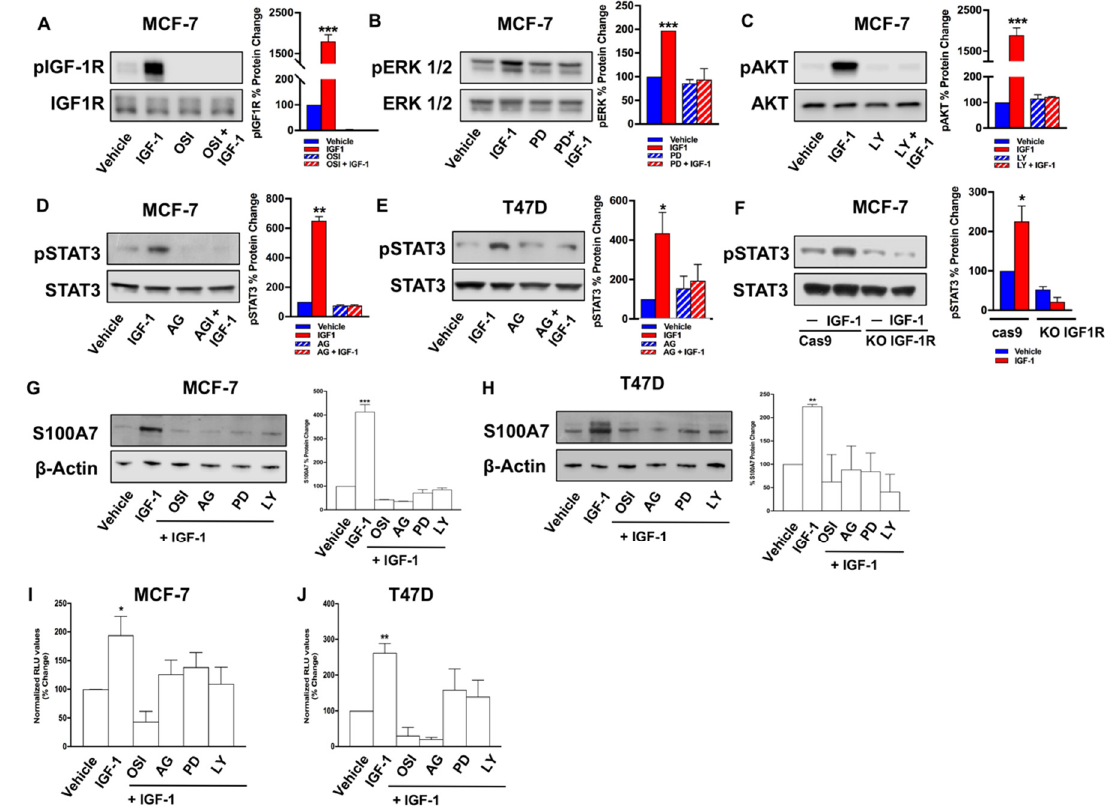
Figure 4. ERK1/2, AKT, and STAT3 signaling pathways are involved in the up-regulation of S100A7 expression induced by IGF-1. Phosphorylation of IGF-1R ( A ), ERK1/2 ( B ), and AKT ( C ) in MCF-7 cells treated with IGF-1 (10 nM, 24 h), alone and in combination with the IGF-1R inhibitor OSI-906 (OSI, 10 µ M) ( A ), the MEK inhibitor PD0325901 (PD, 300 nM) ( B ), as well as the PI3K/AKT inhibitor LY294002 (LY, 10 μ M) ( C ). In MCF-7 ( D ) and T47D ( E ) cells, the exposure to IGF-1 (10 nM, 24 h) induced the phosphorylation of STAT3 (Y705), which was prevented in the presence of the JAK/STAT inhibitor Tyrphostin AG490 (AG, 25 μ M). ( F ) STAT3 phosphorylation (Y705) in response to IGF-1 (10 nM, 24 h) is absent in MCF-7 cells knock-out for IGF-1R (MCF-7 KO-IGF1R) via CRISPR genome editing, but present in MCF-7 control cells (MCF-7 cas9). The up-regulation of S100A7 protein expression was prevented in MCF-7 ( G ) and T47D ( H ) cells treated with IGF-1 (10 nM, 48 h), alone and in combination with OSI (OSI-906, 10 μ M), AG (AG490, 25 μ M), PD (PD0325901, 300 nM), and LY294002 (LY, 10 μ M). β -actin, IGF-1R, ERK1/2, AKT, STAT3 serve as loading controls, as indicated. Data shown are the mean ± SEM of at least two independent experiments. Evaluation of luciferase activity in MCF-7 ( I ) and T47D ( J ) cells transiently transfected with a S100A7 (pS100A7) promoter construct and treated with IGF-1 (10 nM, 18 h) in the presence of OSI (10 µ M), AG (25 µ M), PD (300 nM), and LY (10 µ M). Luciferase activity was normalized to the internal transfection control. Results are expressed as the % change of normalized RLU values relative to vehicle-treated cells. Data shown are the mean ± SEM of at least two independent experiments performed in triplicate. (*) p < 0.05; (**) p < 0.01; (***) p <